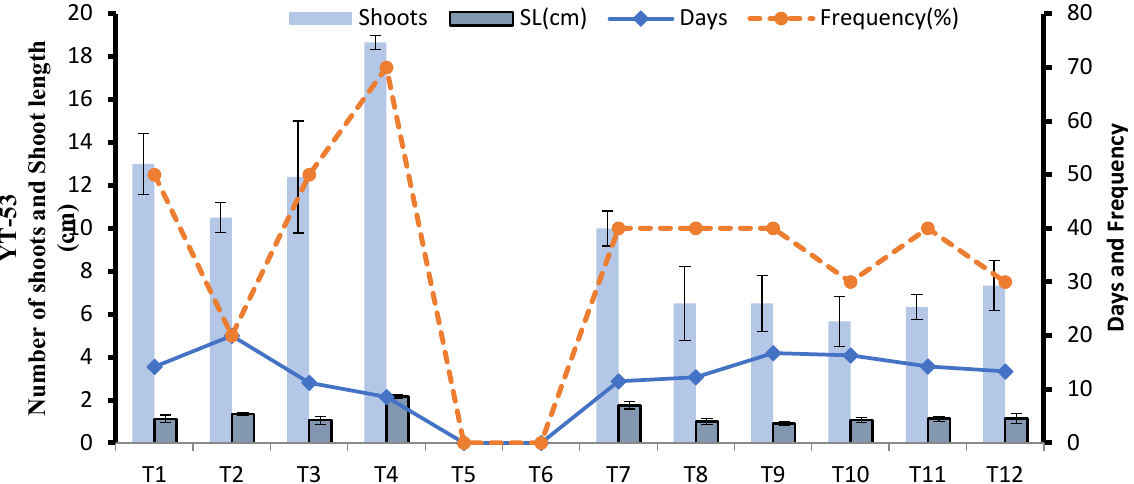
Figure 7. Effect of different media compositions on shoot induction in terms of shoot length, number of shoots, number of days, frequency in YT-53.